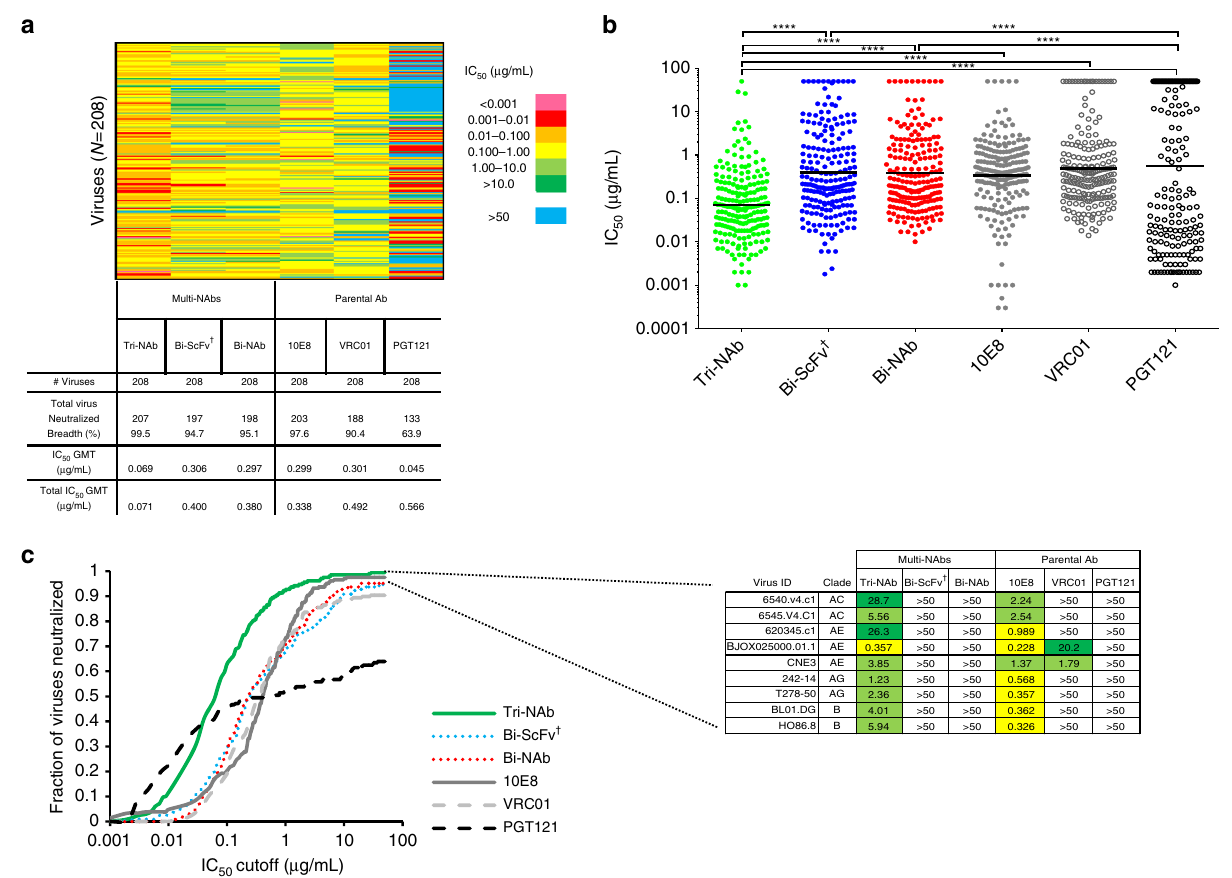
Fig. 6 Neutralization breadth and potency of trispeci fi c antibodies. a Neutralization breadth of the parental, bispeci fi c and trispeci fi c antibodies was tested against a panel of 208 viral strains. Heat maps of IC 50 , breadth and potency are shown as in Fig. 4a. b Scatter plots of IC 50 titers in which each virus is represented by an individual dot. Total IC 50 GMT value is indicated by a black line for each antibody. Statistical differences in neutralization were evaluated using non-parametric t -test (Wilcoxon matched-pairs signed rank test) with * p < 0.05, ** p < 0.01, *** p < 0.001, **** p < 0.0001. c Potency-breadth curves comparing the Tri-NAb to the Bi-NAb as well as the parental (left panel) and summary of IC 50 ( μ g/mL) against viruses that are resistant to Bi-NAb but sensitive to the Tri-NAb (right panel). † indicates that the IC 50 was adjusted by a factor of 3 to account for the molarity difference between the